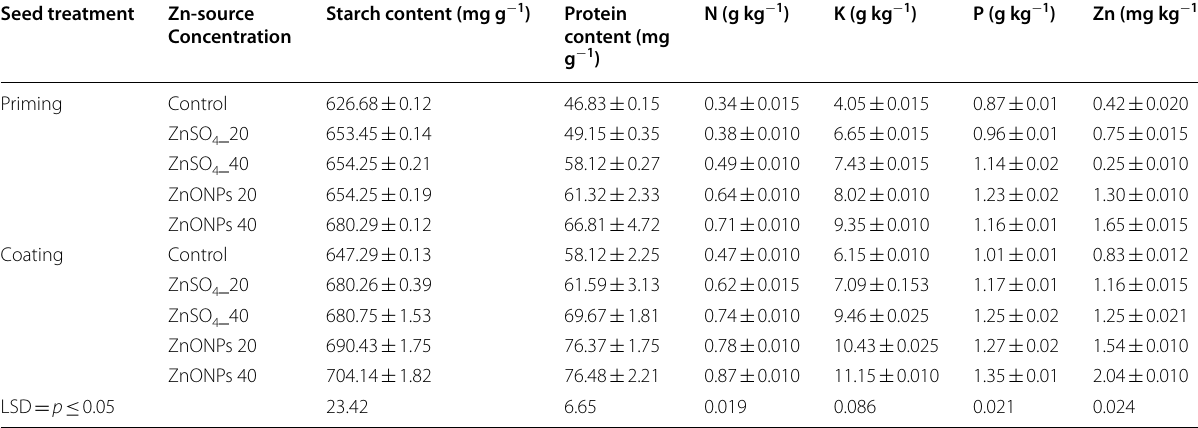
Values depict the average mean